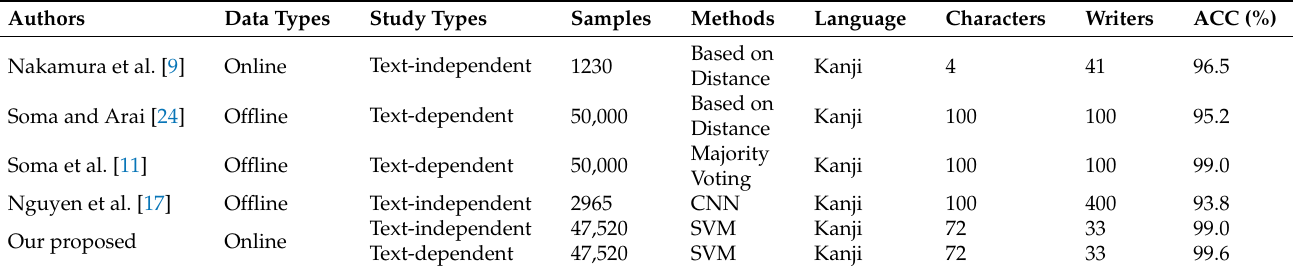
Table 7. Comparison of our proposed system against similar existing